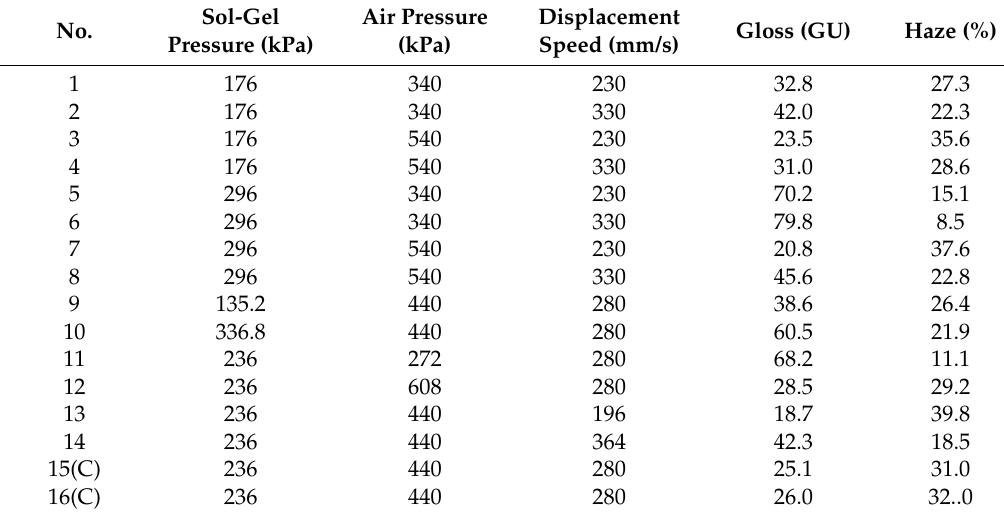
Table 3. Experimental results of the central composite